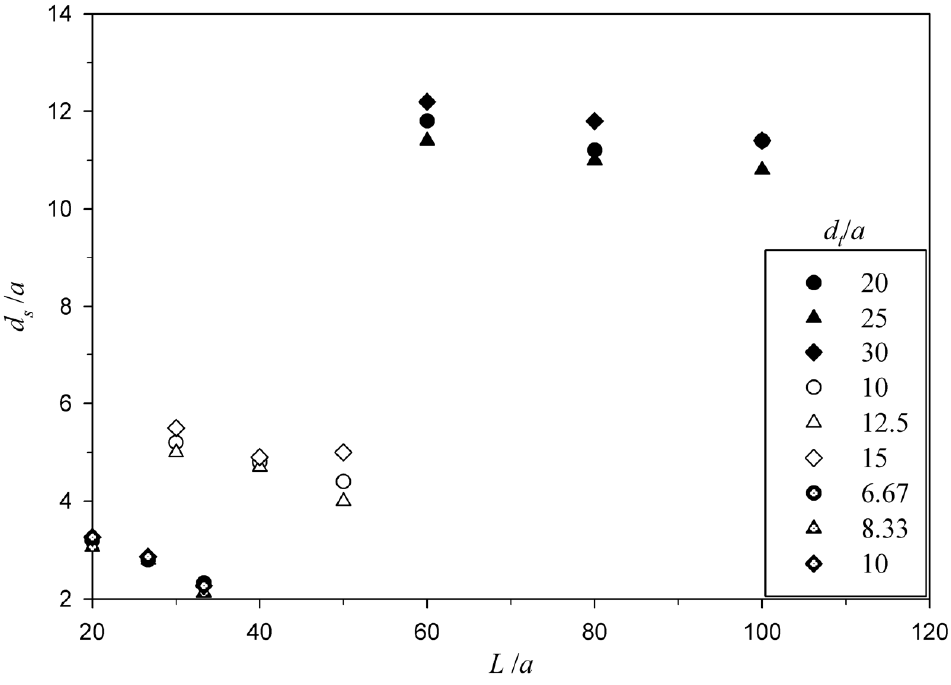
Figure 6. d s / a variation with L / a for various a and d t.